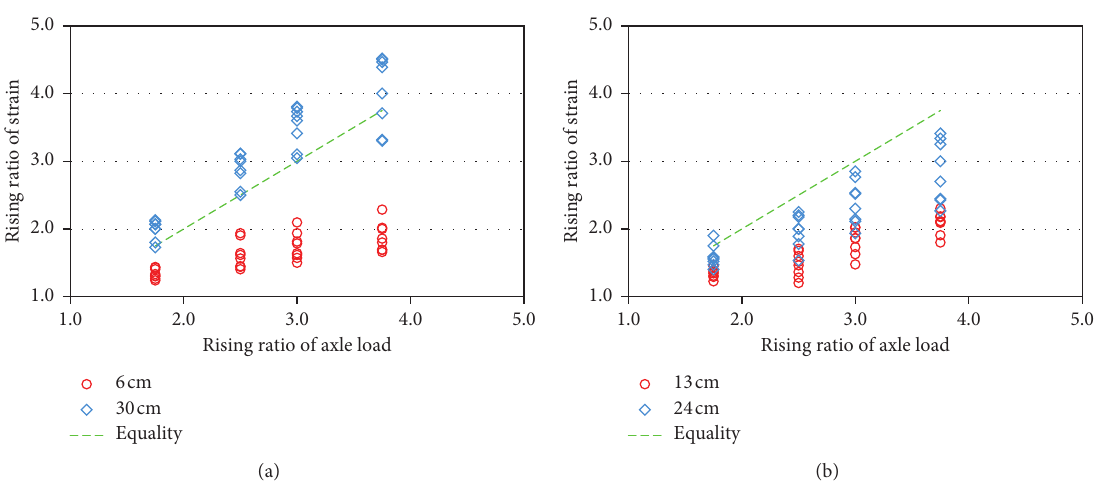
Figure 10: The rising ratio of axle loads vs. the rising ratio of strains for (a) flexible pavement and (b) semirigid pavement.